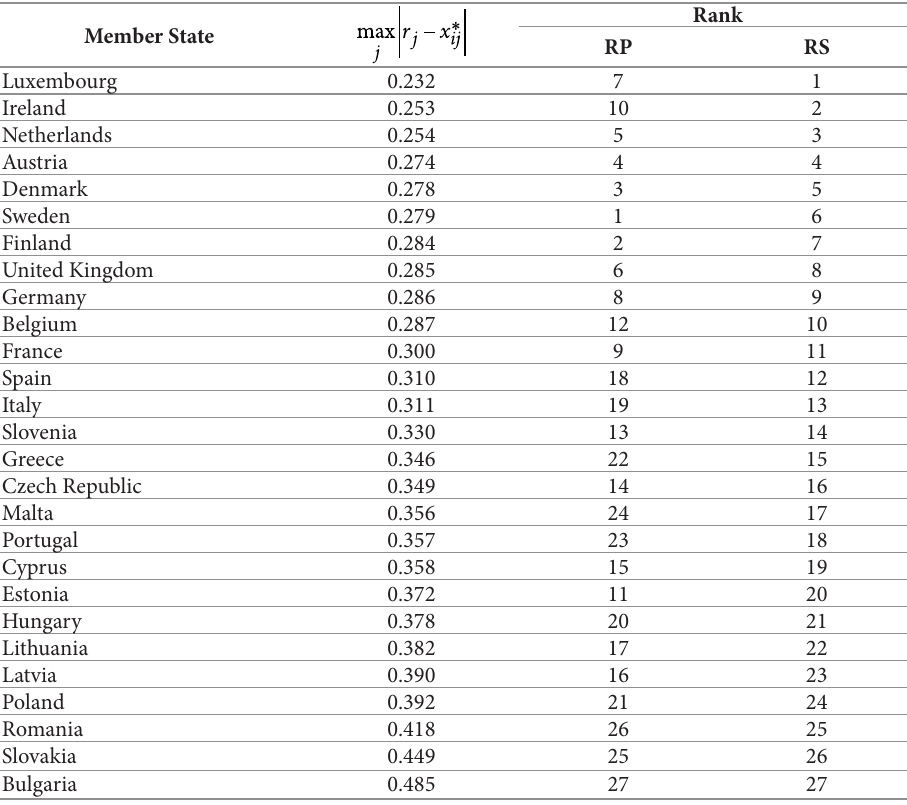
Table 2. Ranks of European Union Member States according to the reference point (RP) approach and ratio system (RS), 2008